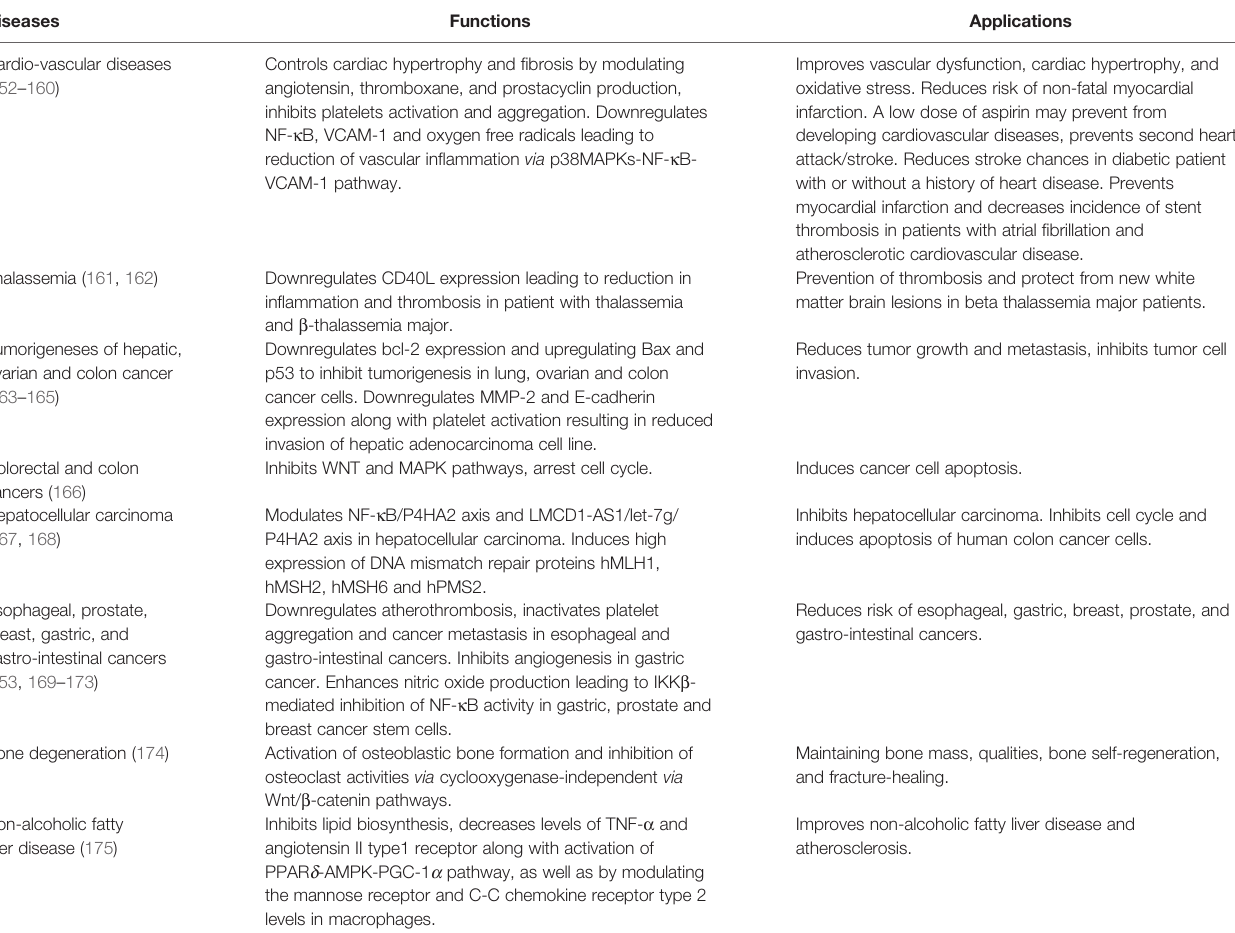
TABLE 1 | Effect of Aspirin on various